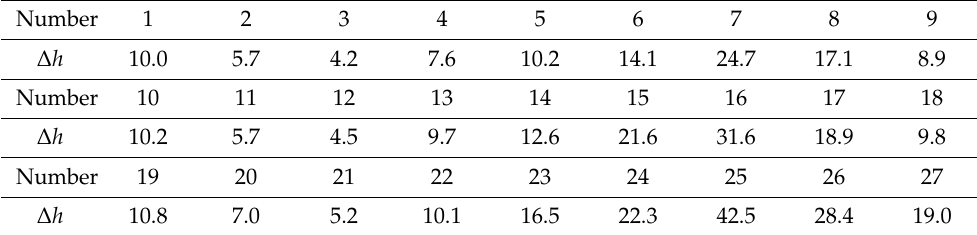
Table 3. Amount of change in the tip of the experimental abrasive grain ( µ